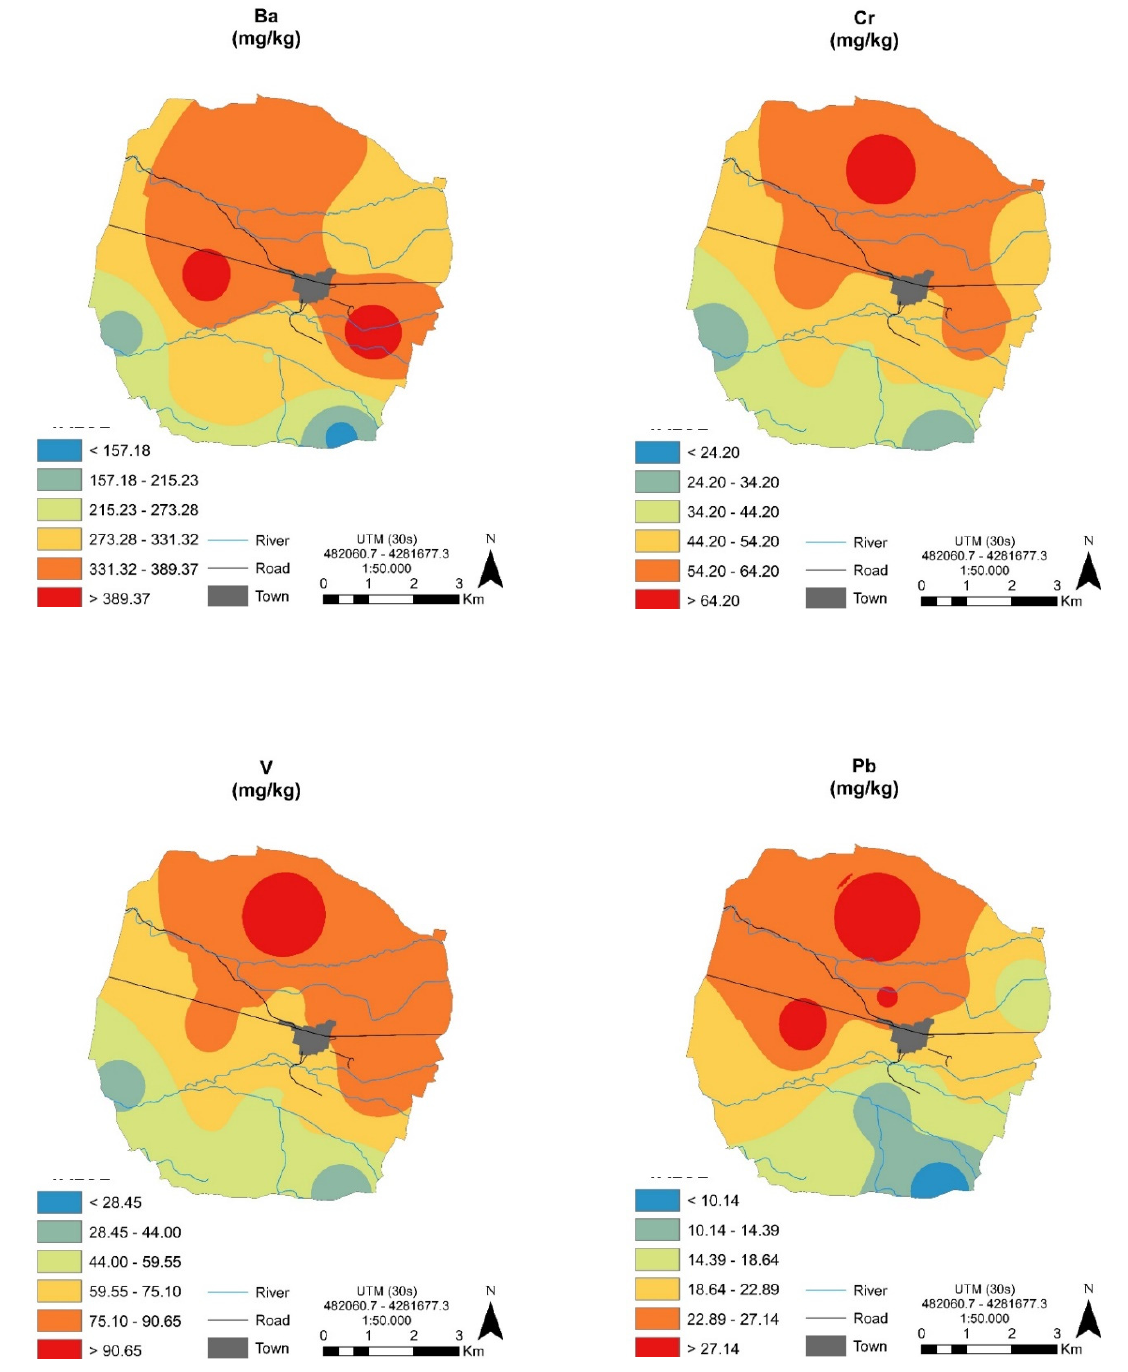
Figure 4. Figure 4. Geo-spatial prediction maps for some trace elements in subsurface soil horizons.